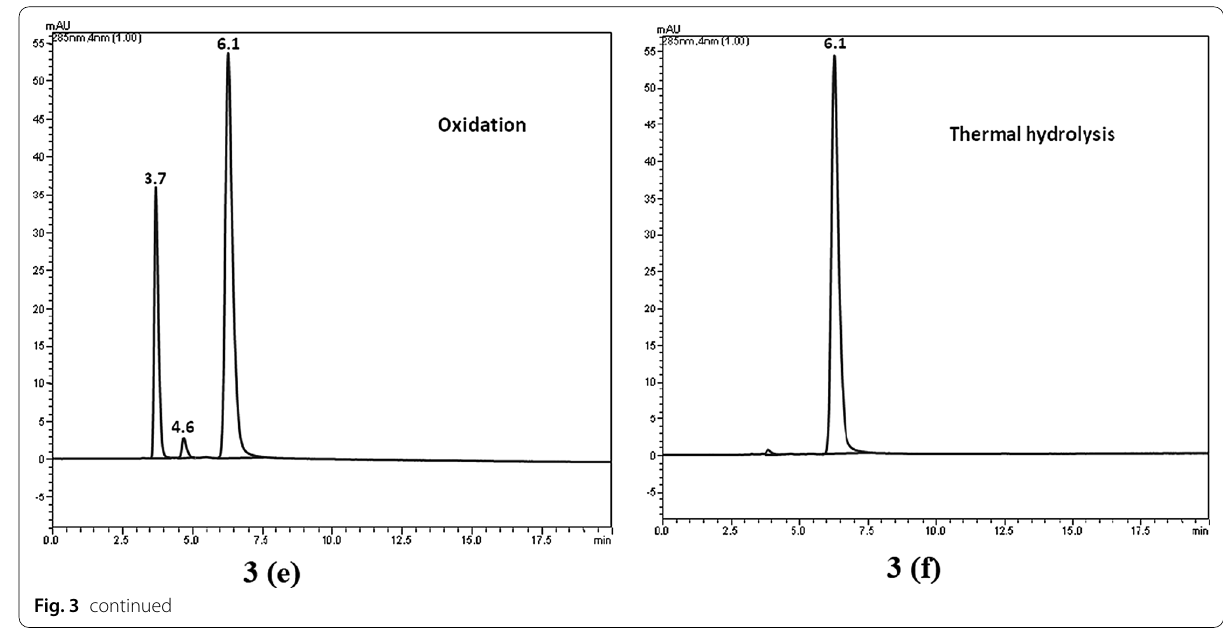
Table 3 Intra- and inter-day precision and accuracy results ( n